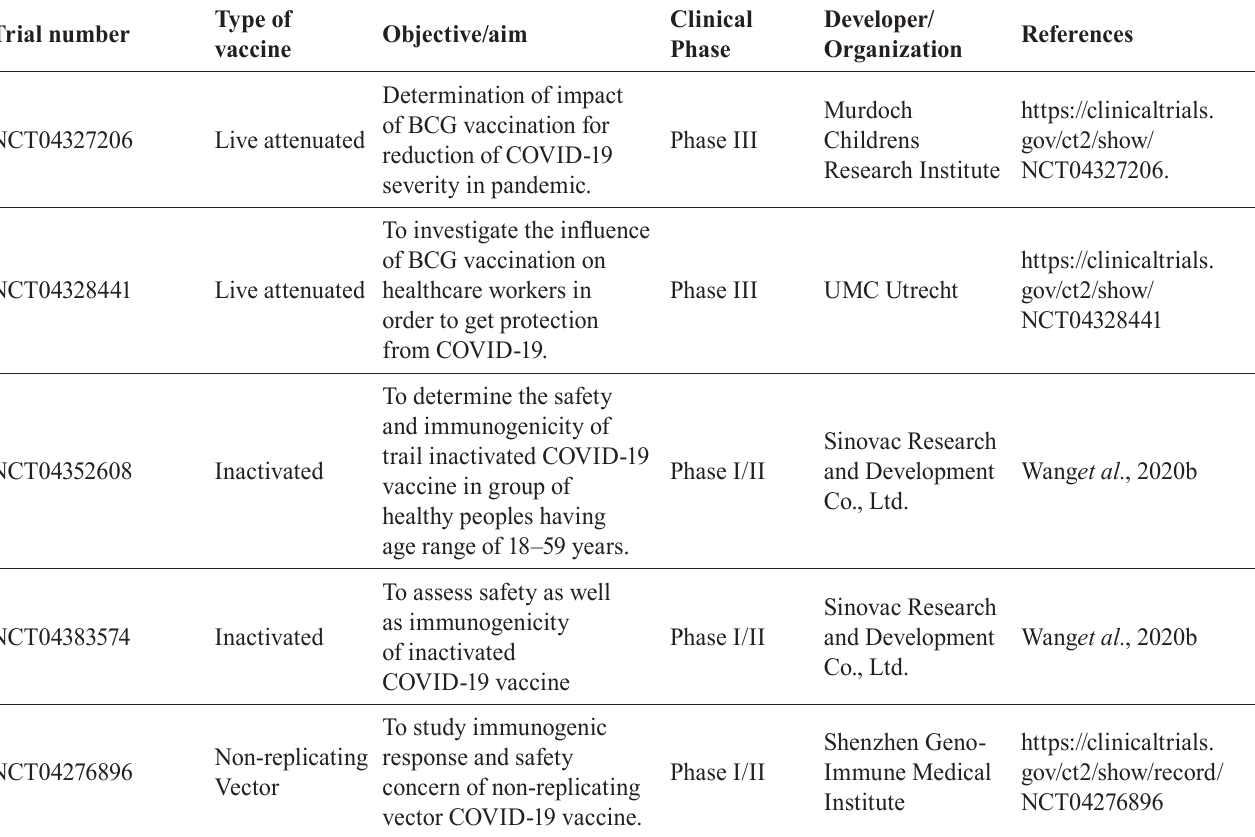
TABLE II - Coronavirus vaccines which are under clinical trials currently